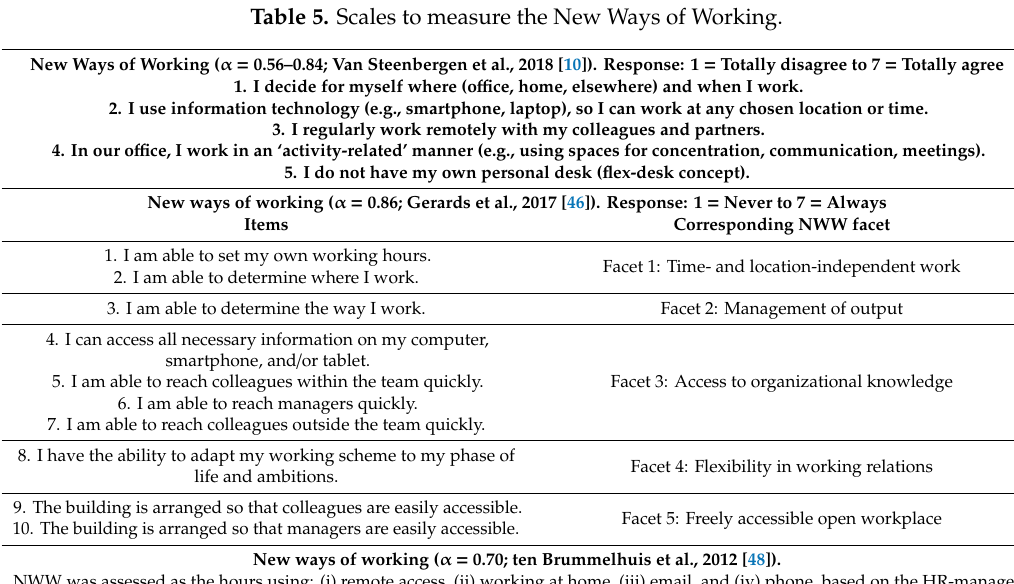
Table 5. Scales to measure the New Ways of